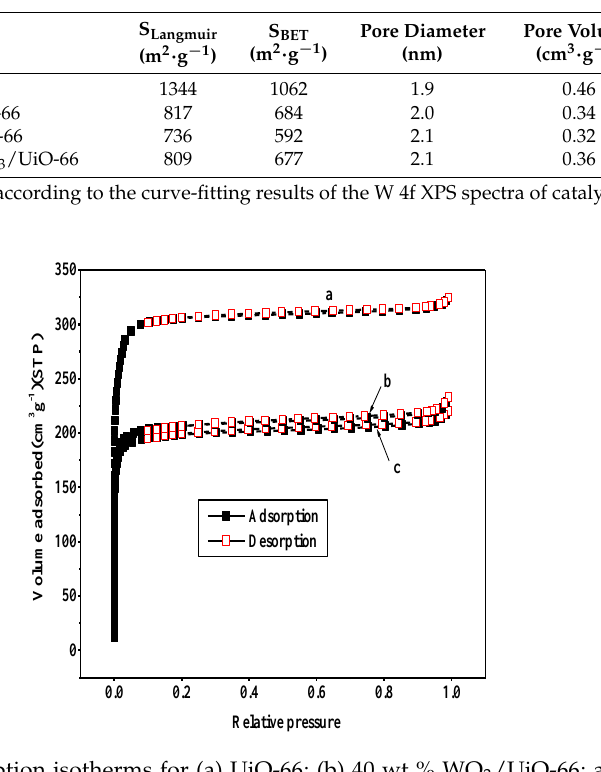
Figure 3. Nitrogen sorption isotherms for (a) UiO-66; (b) 40 wt % WO 3 /UiO-66; and, (c) 15 wt % B 2 O 3 -40 wt % WO 3 /UiO-66.